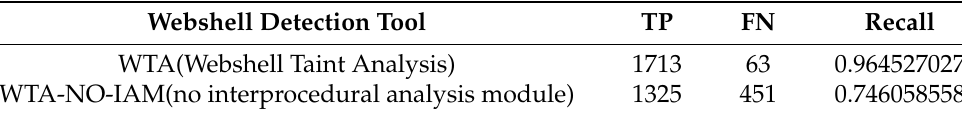
Table 7. Performance comparison between WTA and WTA-NO-IAM.